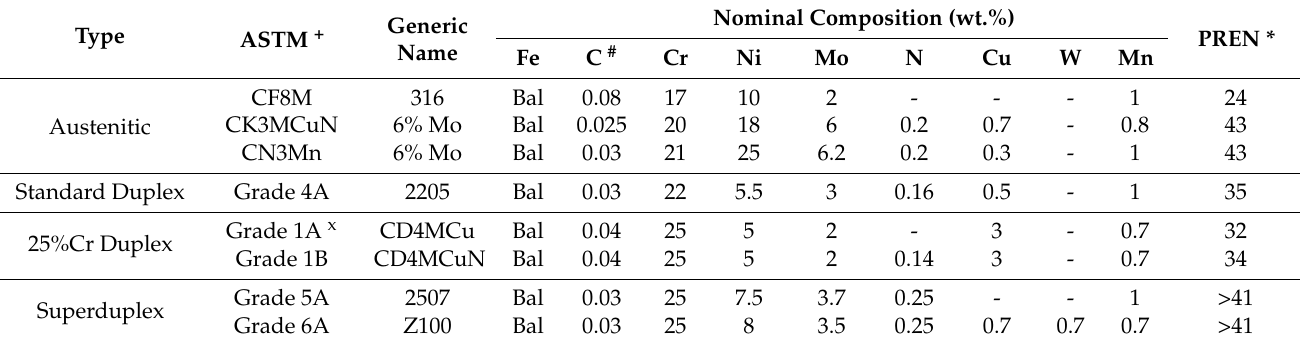
Table 2. The nominal compositions of some commonly used cast duplex stainless